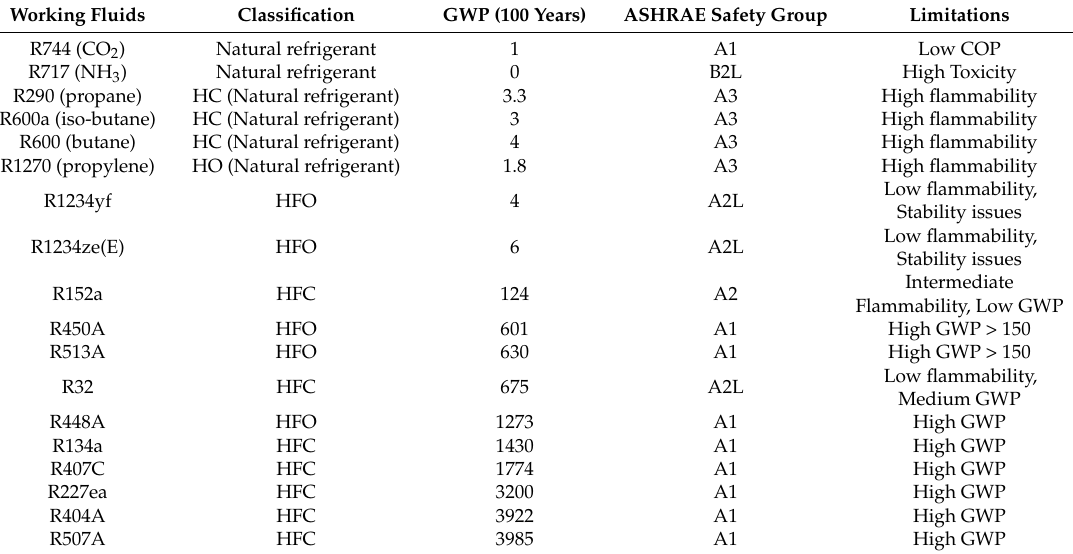
Table 1. Refrigerants and their characteristics